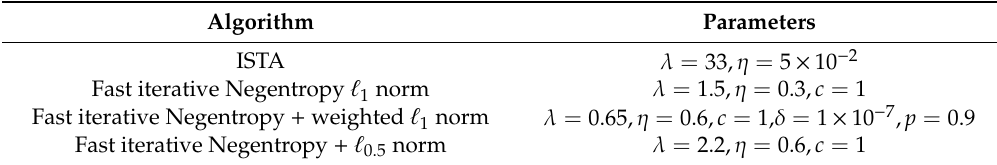
Table 2. The parameter setting of algorithms in image denoising